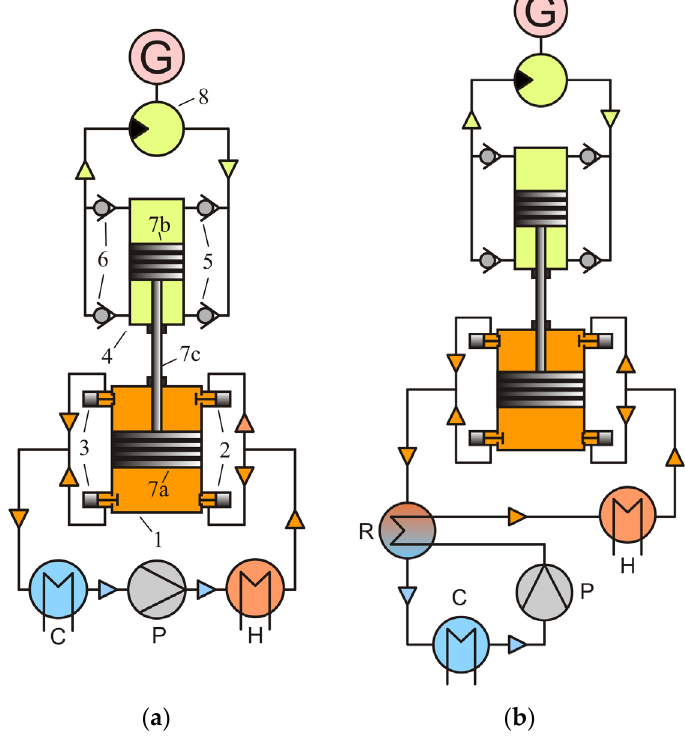
Figure 1. ( a ) Simplest non-regenerative Worthington-type engine, ( b ) regenerative Worthington- type engine. Pump (P), heater (H), recuperator (R), cooler (C) and electric generator (G). Driving cylinder (1), admission valves (2), exhaust valves (3), pumping cylinder (4), suction valves (5), dis- charge valves (6), driving piston (7a), pumping piston (7b), piston rod (7c) and hydraulic motor (8).